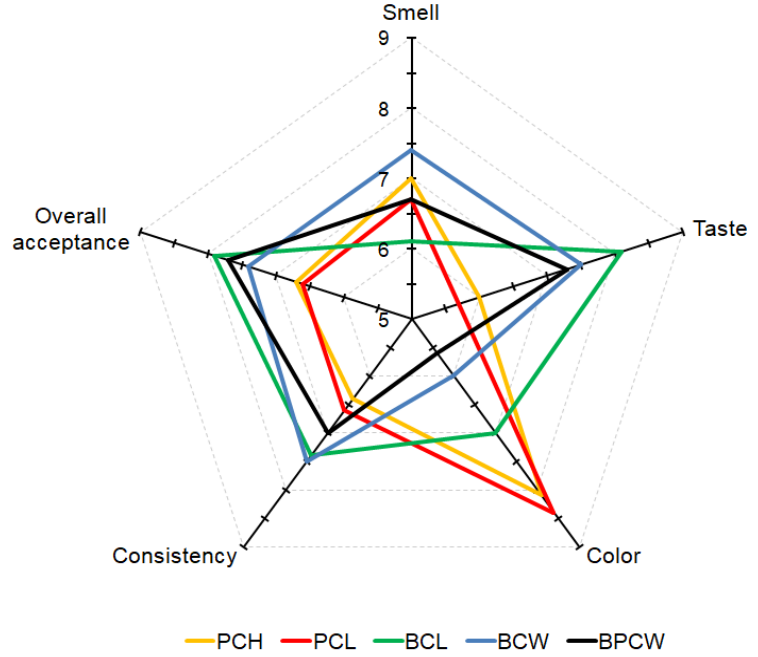
Figure 1. Sensory scores of different